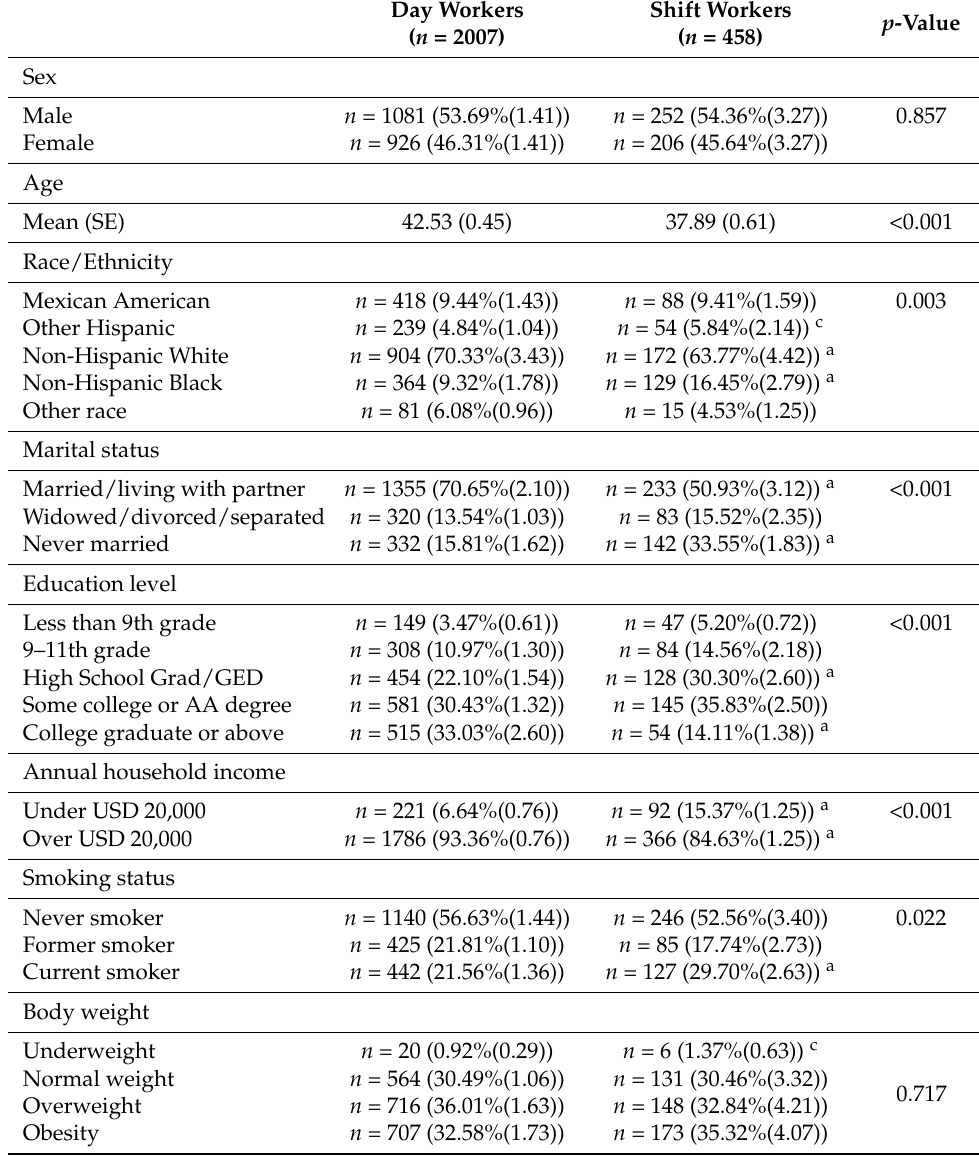
Table 1 legend: Column percentages may not equal 100% due to rounding. The p -value is based on STATA’s design-based Rao–Scott F -test and tests for a potential association between shiftwork status and the respective variable (categorical variables only). a : Indicates significant differences in the weighted proportions; c : estimate considered unreliable per NHCS analytic guidelines and based on STATA’s postestimation command